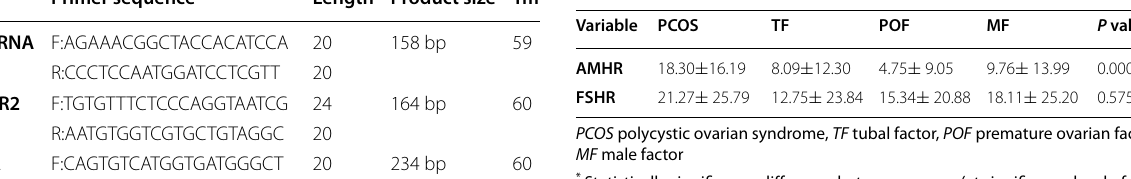
Table 3 The expression level of AMHR2 and FSHR genes in terms of etiologic